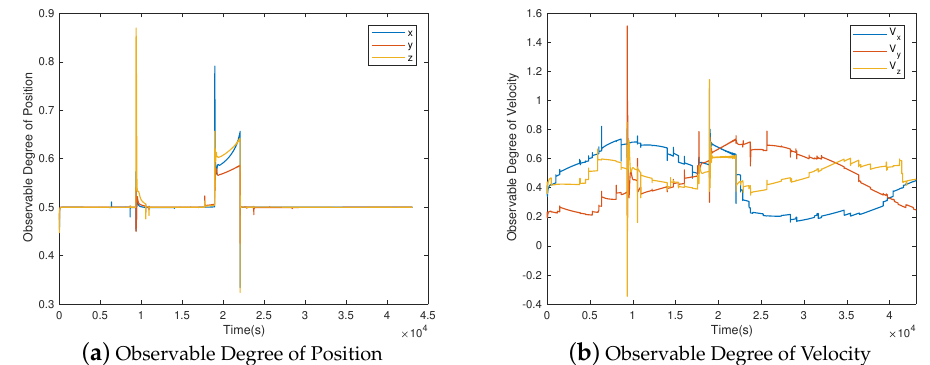
Figure 4. ( a , b ) show the observable degree of position and velocity respectively. The abscissa is sampling time.